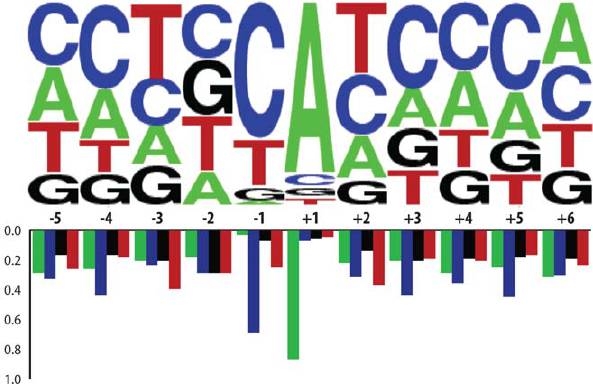
Figure 2. Nucleotide frequency surrounding pri–miRNA tran- scriptional start sites. Nucleotide frequencies surrounding transcrip- tional start sites (as determined from 5 9 RACE products) are shown using sequence logos [121,122]. TSSs are predominately marked by an adenine at the + 1 position and a cytosine at the 2 1 position.